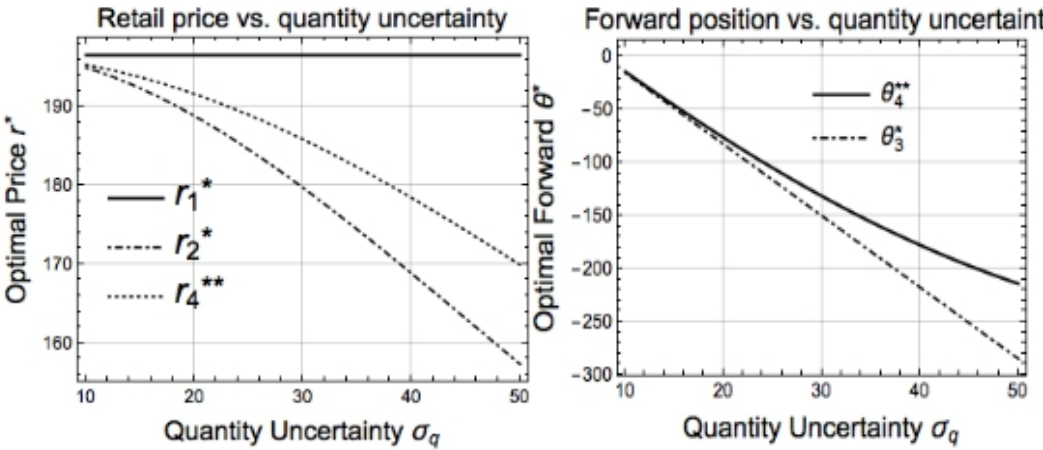
Figure 4. Comparison of r ∗ , r ∗ , and r ∗∗ as from Theorems 1, 2, and 4 as a function of quantity volatility σ q (left panel), and θ ∗∗ and θ ∗ from Theorems 4 and 3 as a function of quantity volatility σ q (right panel). The retail price of models 1 and 3 are identical by definition, so we only plot the retail price of model 1. All other parameters were set according to the benchmark setup given in Table 2.